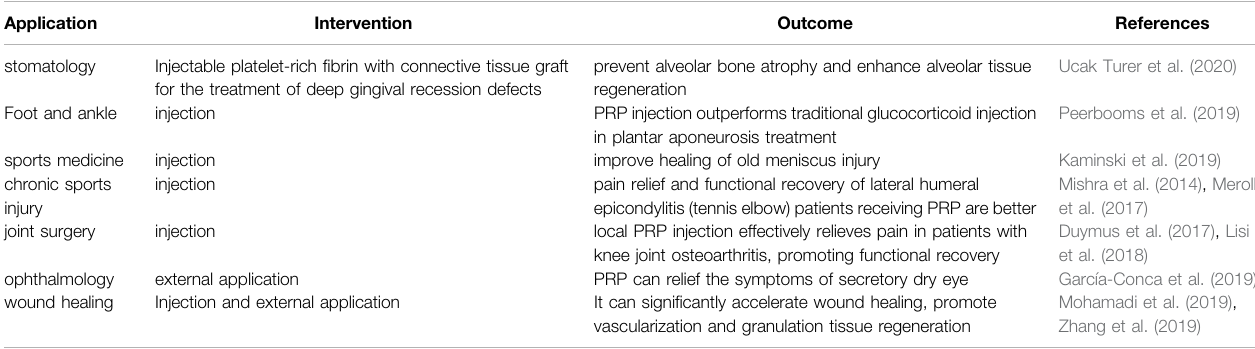
TABLE 1 | Summary of clinical application of